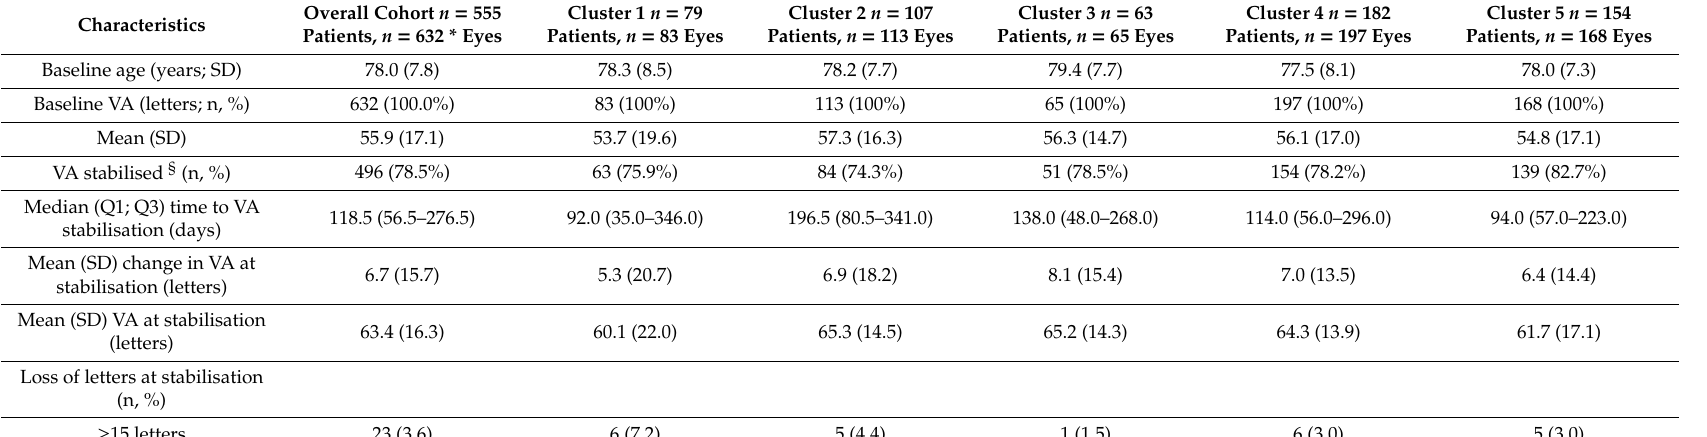
Table 4. Visual acuity and change from baseline for overall cohort and